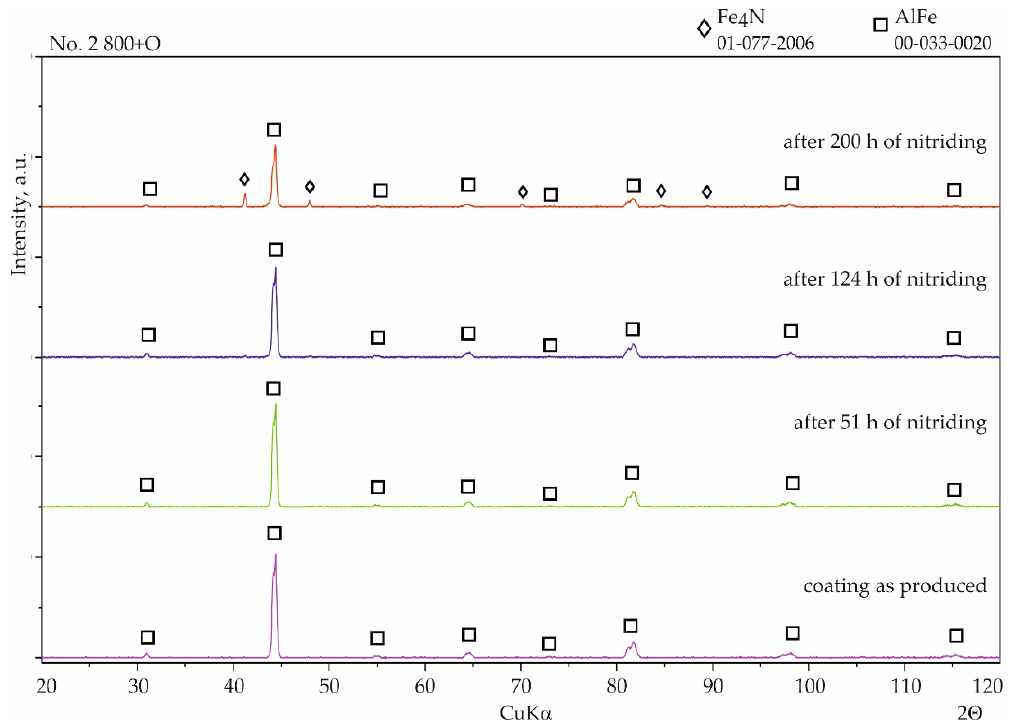
Figure 10. Qualitative X-ray structure analysis (XRD) of the Al–Si coating on 1.4541 steel produced at 800 °C with additional oxidation in 1000 °C during 5 min; from the bottom: in the initial state; after 51 h of nitriding; after 124 h of nitriding; and after 200 h of nitriding. With coating No. 3, long-term exposure of the samples to the aggressive ammonia atmosphere had no effect on the surface morphology (Figure 11a). Identical results were obtained for the samples provided with coating No. 4, whereas with coating No. 2, many